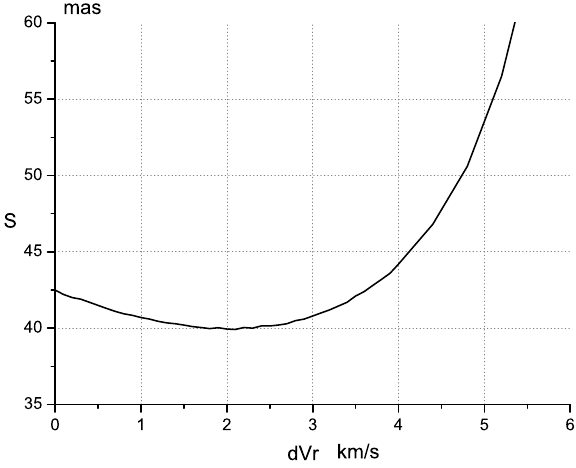
Fig. 7. The relative radial velocity at the instant 2009.0 for the outer pair NS is estimated as a minimum of this function S ( ∆V ΣM = 6.1 M ⊙